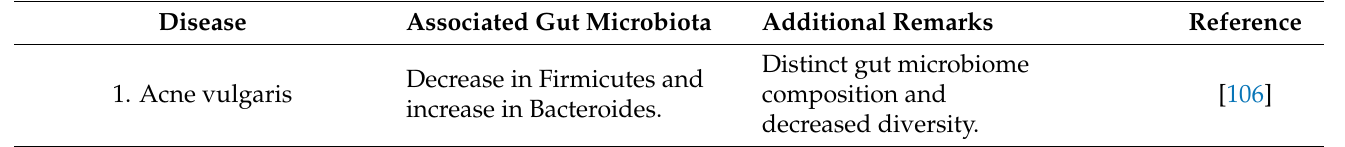
Table 2. Gut microbiota associated with nine common skin